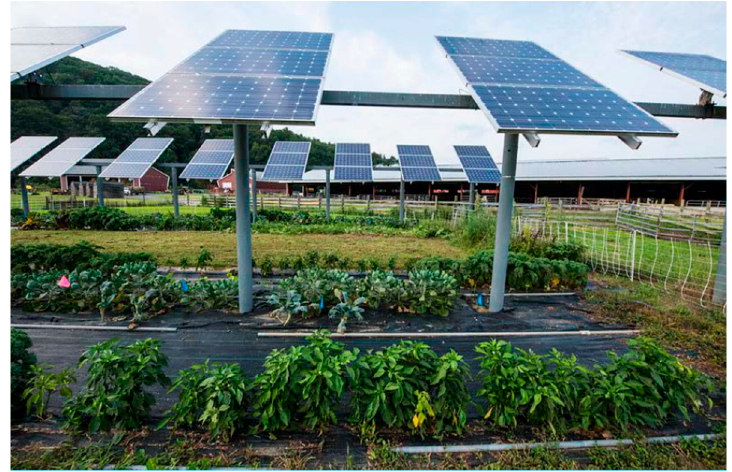
Figure 5. Panels spacing for an experiment in the USA [29].